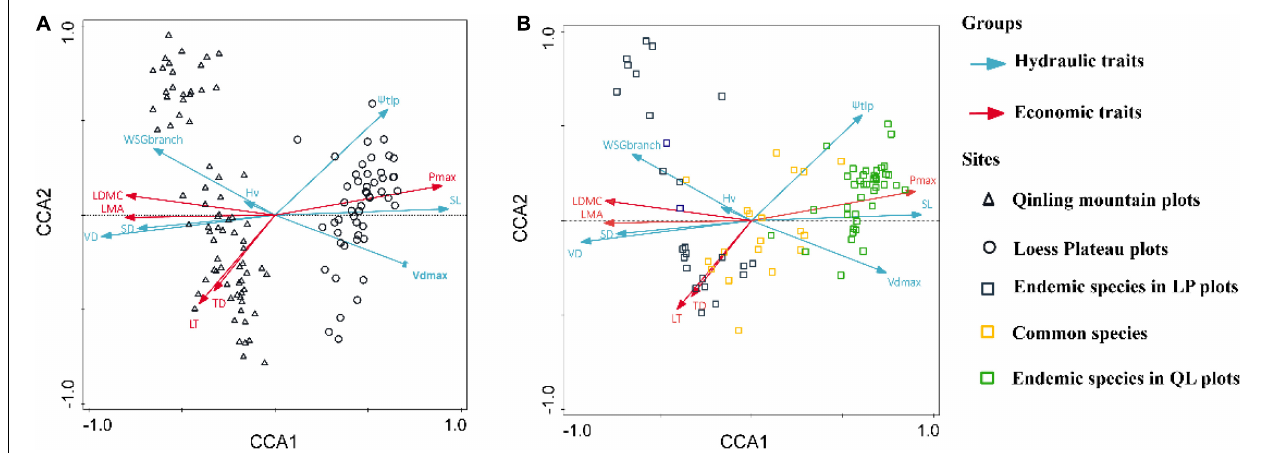
FIGURE 3 | Community-weighted trait bi-plot for canonical correlation analysis, showing the effects of functional traits on the community species composition and plot distribution between the Loess Plateau and Qinling Mountains. (A) The effect of functional traits on the plot distribution. (B) The effect of functional traits on the community species composition. The ordination is based on community-weighted mean traits, with traits weighted for each species by its relative abundance in the community. Trait abbreviations are given in Table 1 .